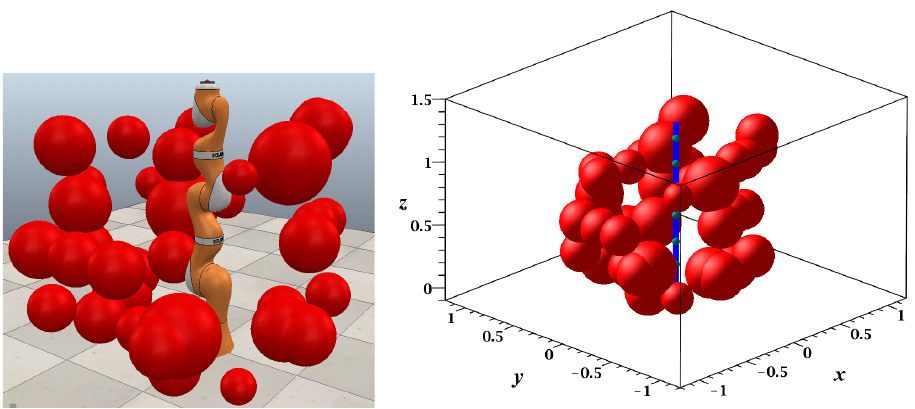
Figure 18. Workspace and configuration space of the KUKA 6 DOF manipulator: Maple Soft and V-REP